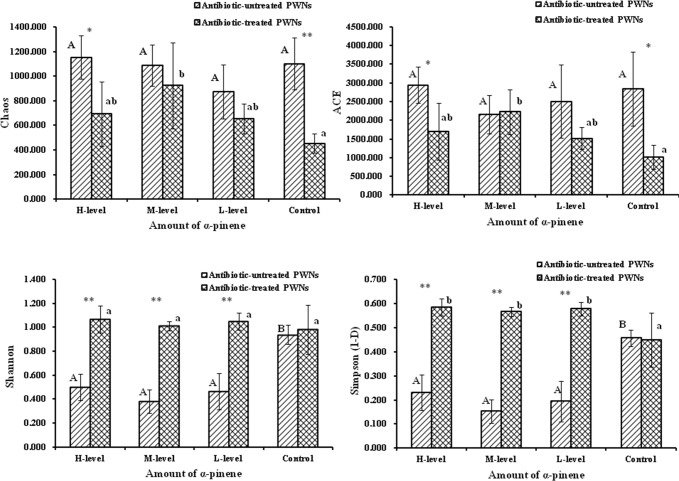
Alpha diversity index of bacteria community.Different letters indicate significant (p < 0.05) differences in OTUs of corresponding nematode groups, as detected by Tukey's HSD test. Dots represent differences between two nematode groups (*p < 0.05, ** p < 0.01).